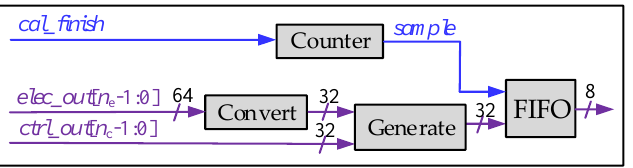
Figure 5. Design of the simulation result output module.